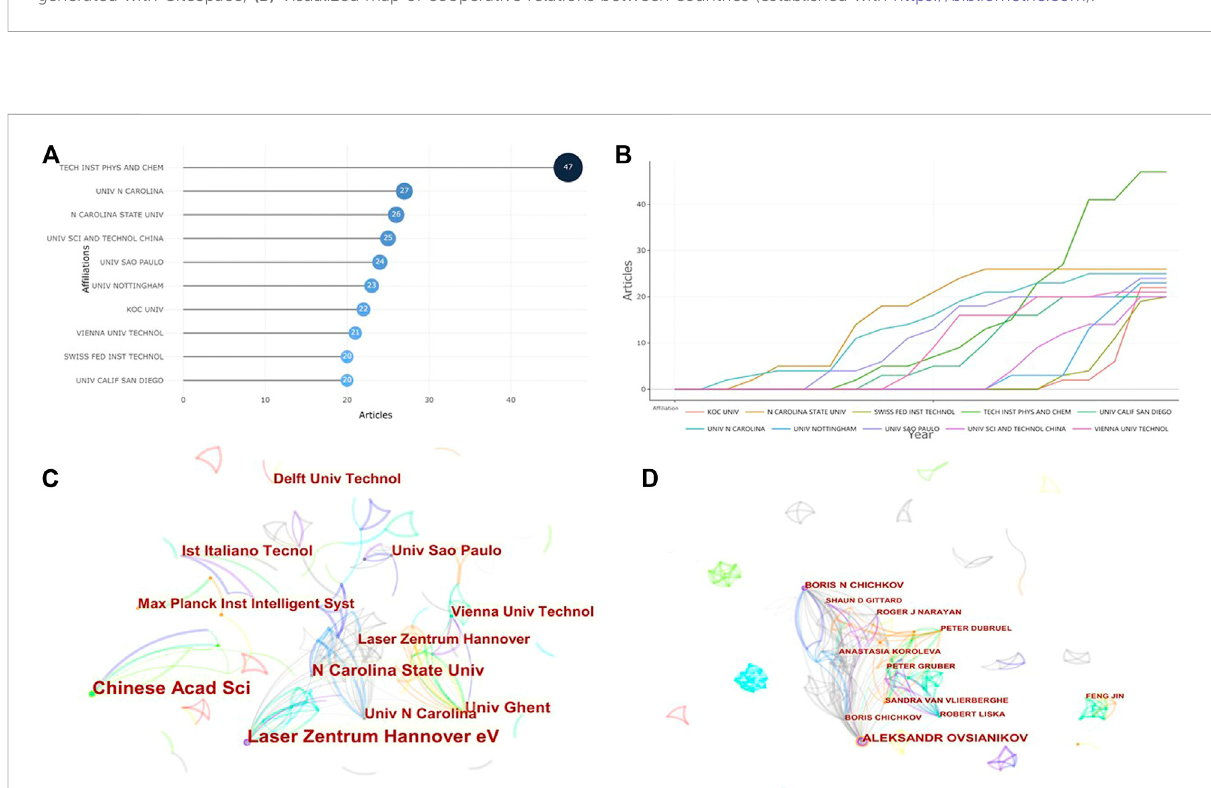
FIGURE 4 Visual analysis of institutions and authors concerning publications of TPP applications in biomedical fi eld. (A) The top 10 institutions with the most published papers; (B) Production of the top 10 institutions with the highest productivity over time. (C) The network of cooperative relations between institutions. (D) The network of cooperative relations between